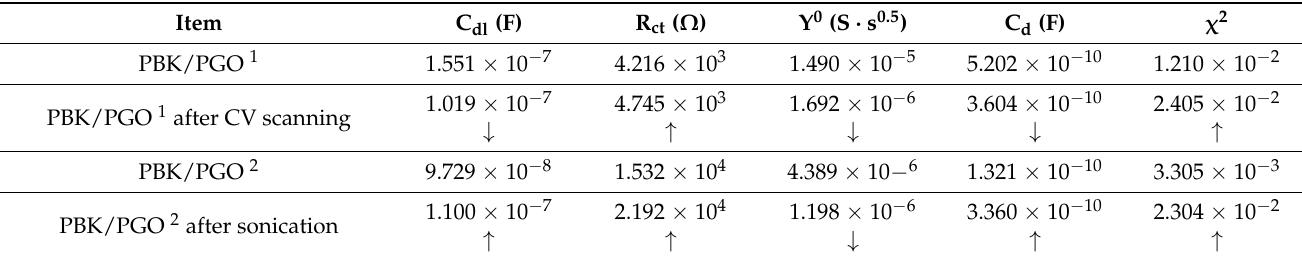
Figure 4. The measured and calculated impedance ( a ) and phase ( b ) spectra before and after 20 min sonication. The inset shows the fitting equivalent circuit. The measured and calculated impedance ( c ) and phase ( d ) spectra before and after 2000 cycles of CV scanning. Table 3. The numerical fitting results of equivalent circuit components of PBK/PGO coated microelectrodes before and after stability tests.